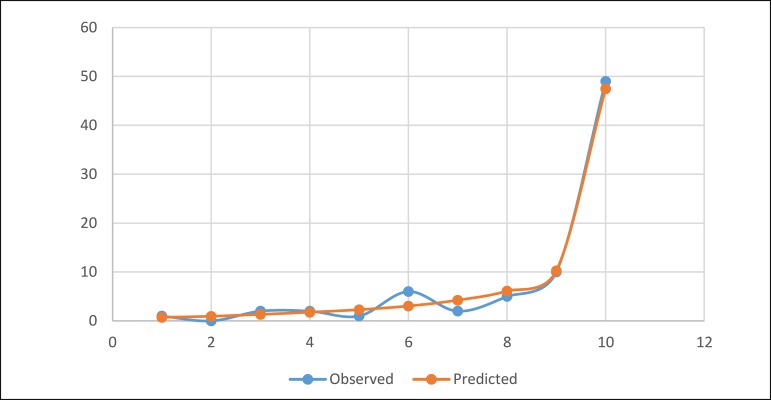
The logistic regression's goodness of fit in the propensity score-match
model. χ2=7.43, P=0.386